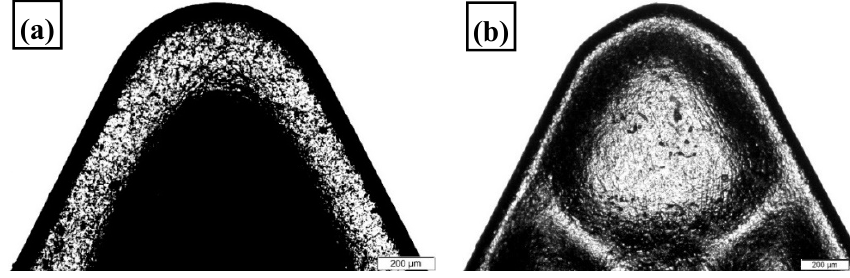
Figure 4. Carbide inserts ( a ) conventional ( DCMT 11 T304-PF GC4325 ) and ( b ) wiper ( DCMX 11 T304-WF GC4325 ).